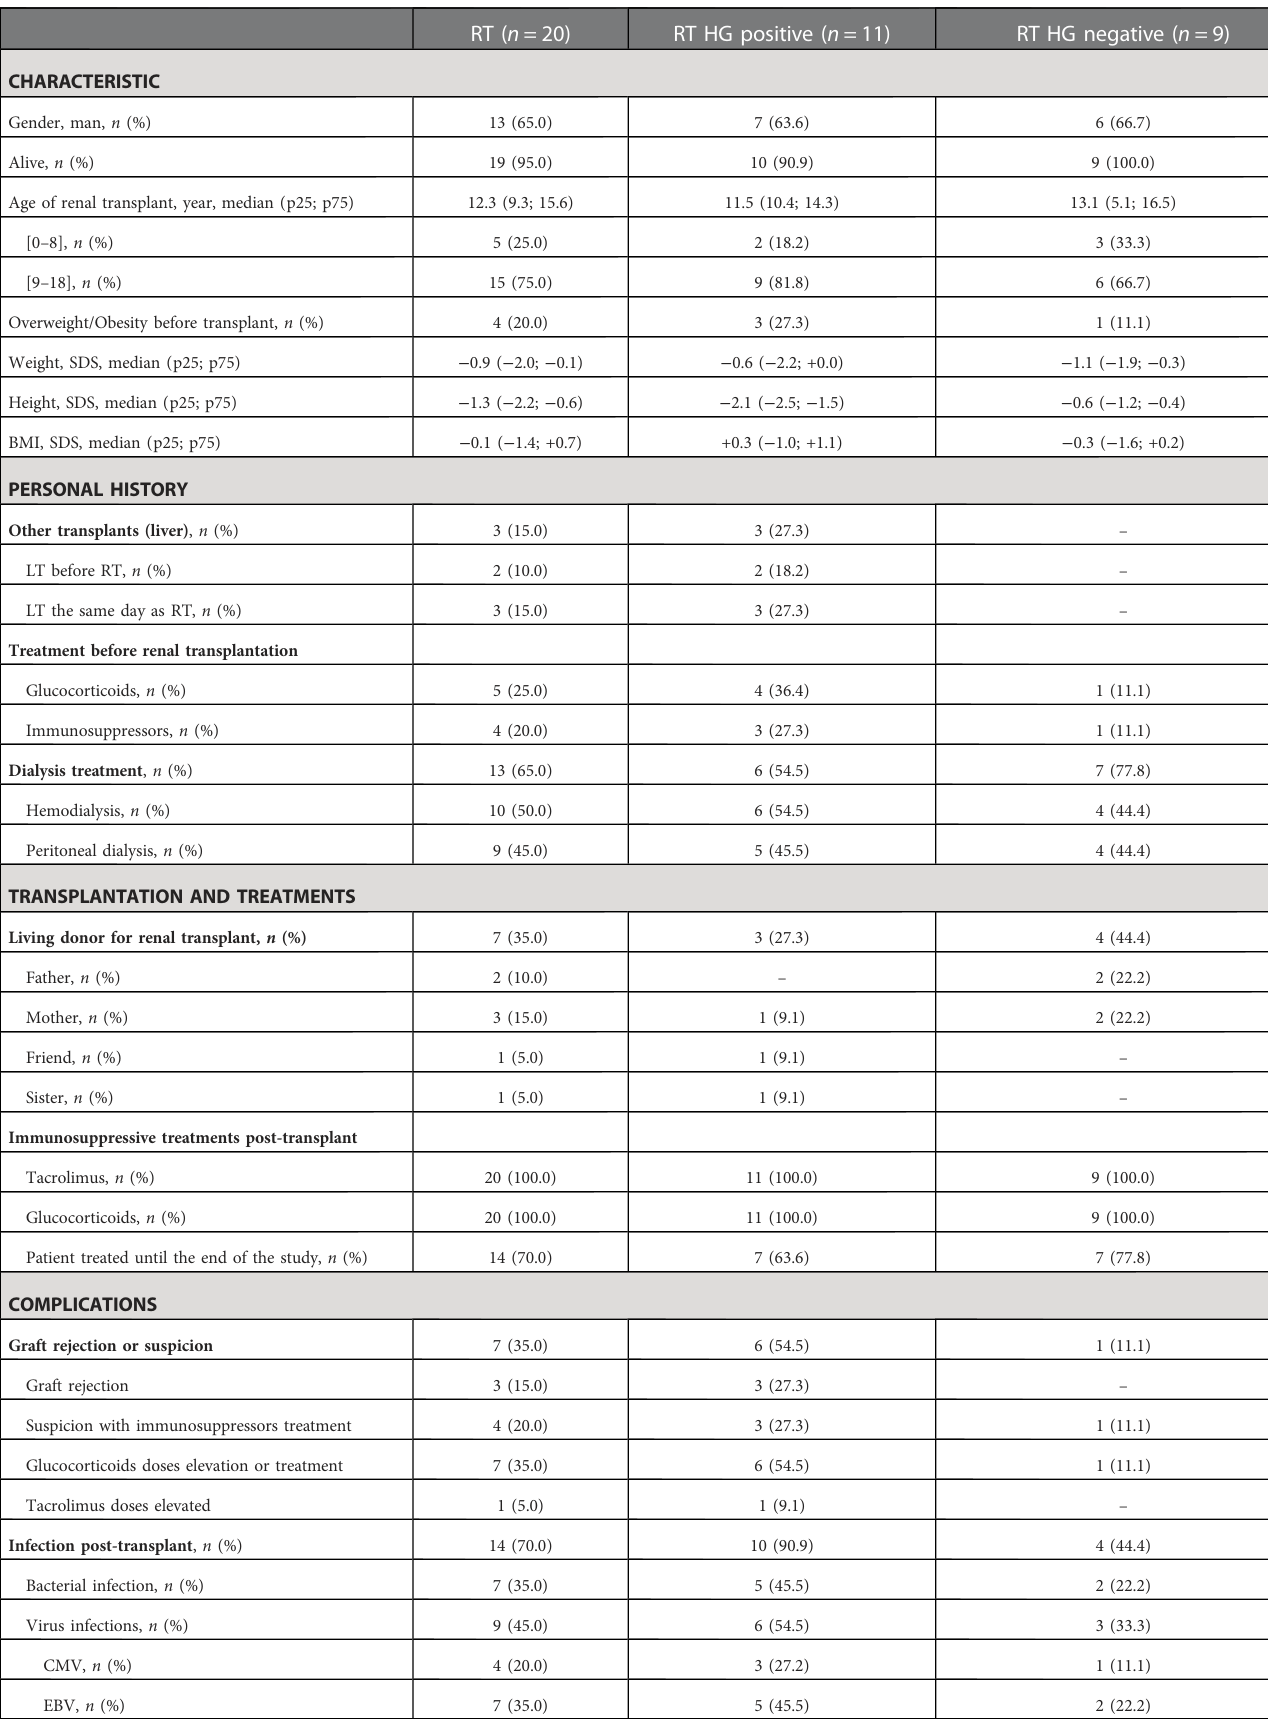
TABLE 2 Characteristic and treatment of pediatric renal transplant patients